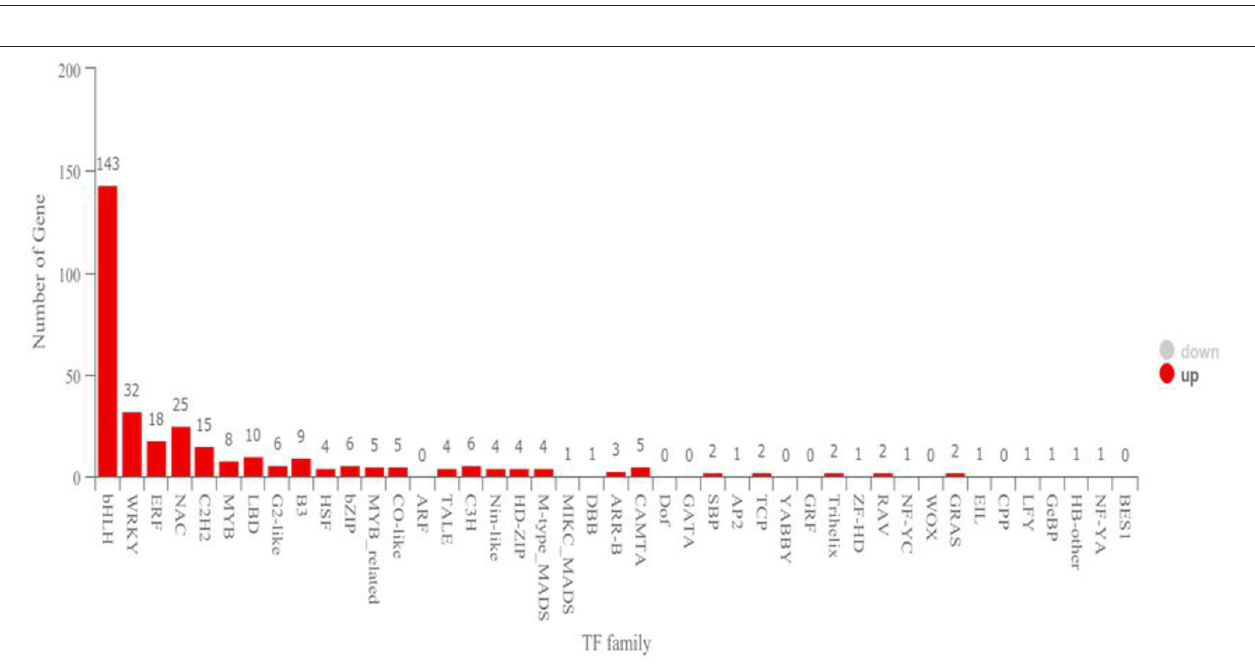
FIGURE 4 | Transcription factor family. The horizontal coordinates are different transcription factor families, and the ordinates are the number of genes that fall into that transcription factor family.